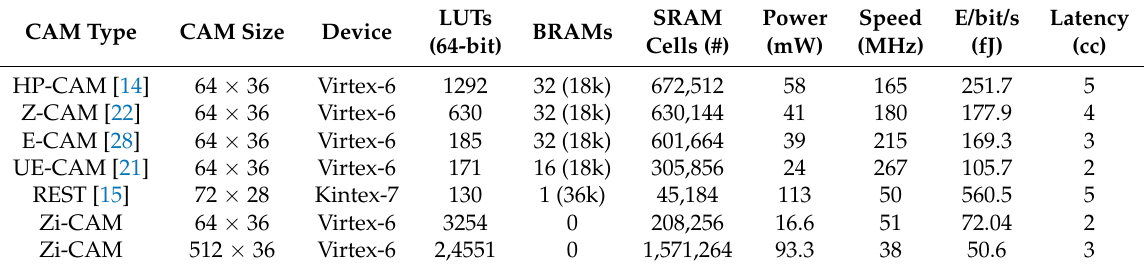
Table 3. Comparison with Other Architectures; cc: clock cycles, E/b/s: